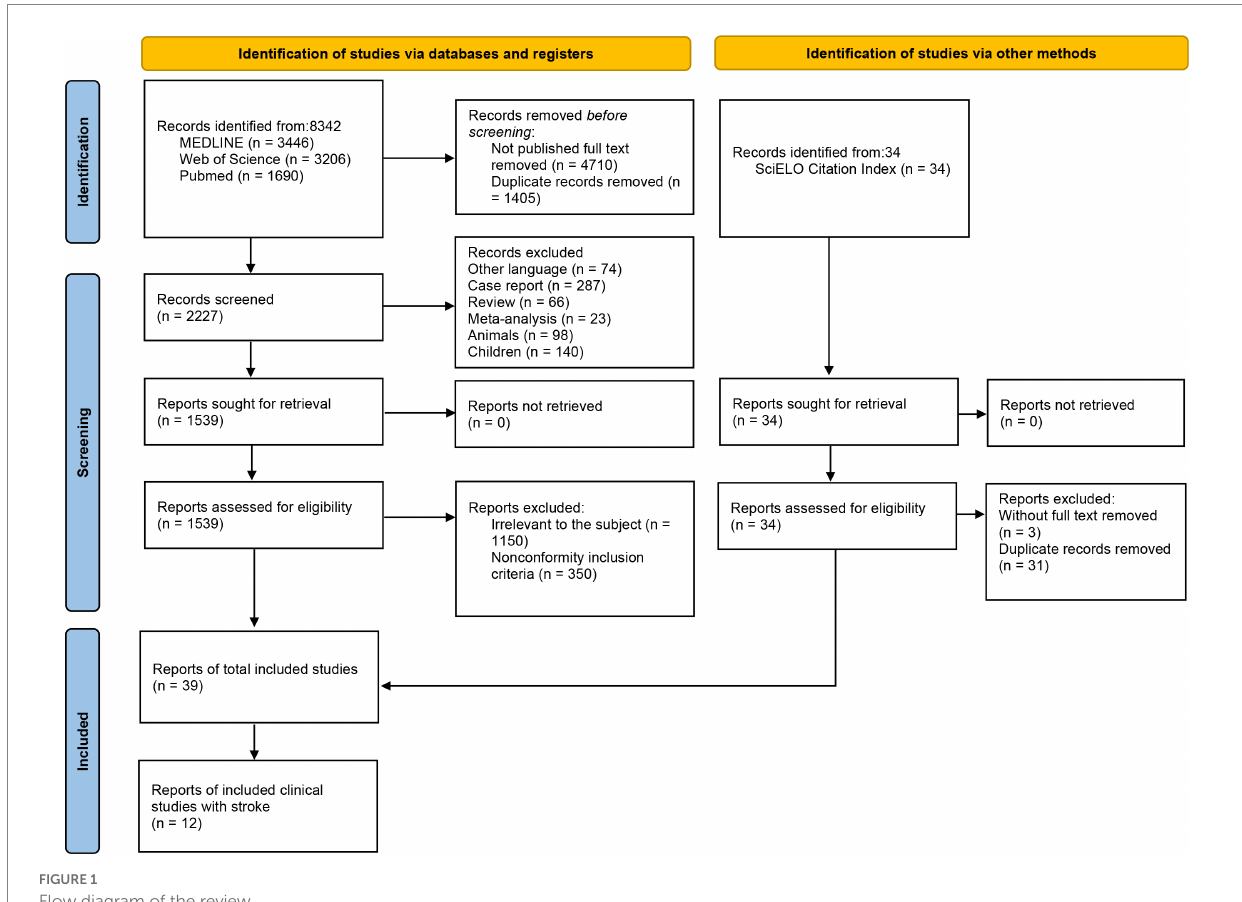
FIGURE 1 Flow diagram of the